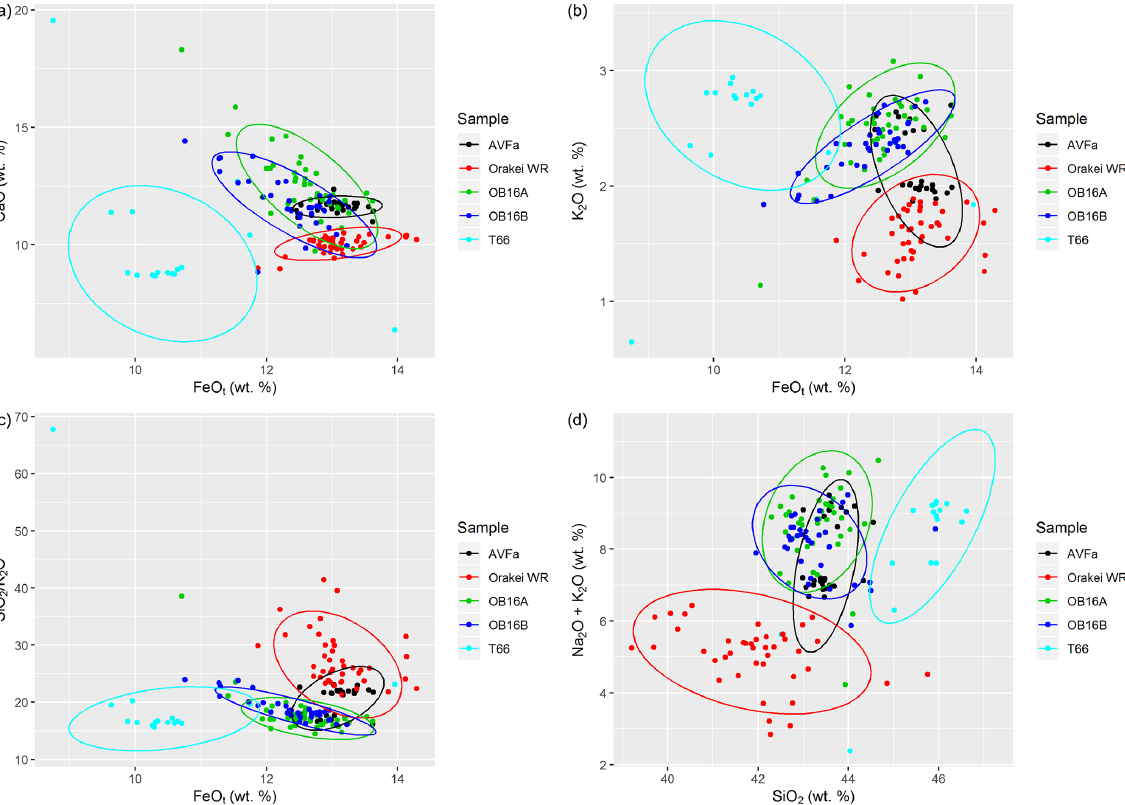
Figure A4. Comparison of sample T66 to AVFa (tephra layer from Glover Park core; correlated to the Orakei eruptive centre; Hopkins et al., 2017), Orakei whole-rock (WR) data, and eruptive material from Orakei in the A and B cores of this study (OB16A, OB16B). Note that T66 overlaps with neither of these samples, suggesting that this is a tephra layer from a different eruption. Ellipses follow a multivariate t distribution (Fox and Weisberg,